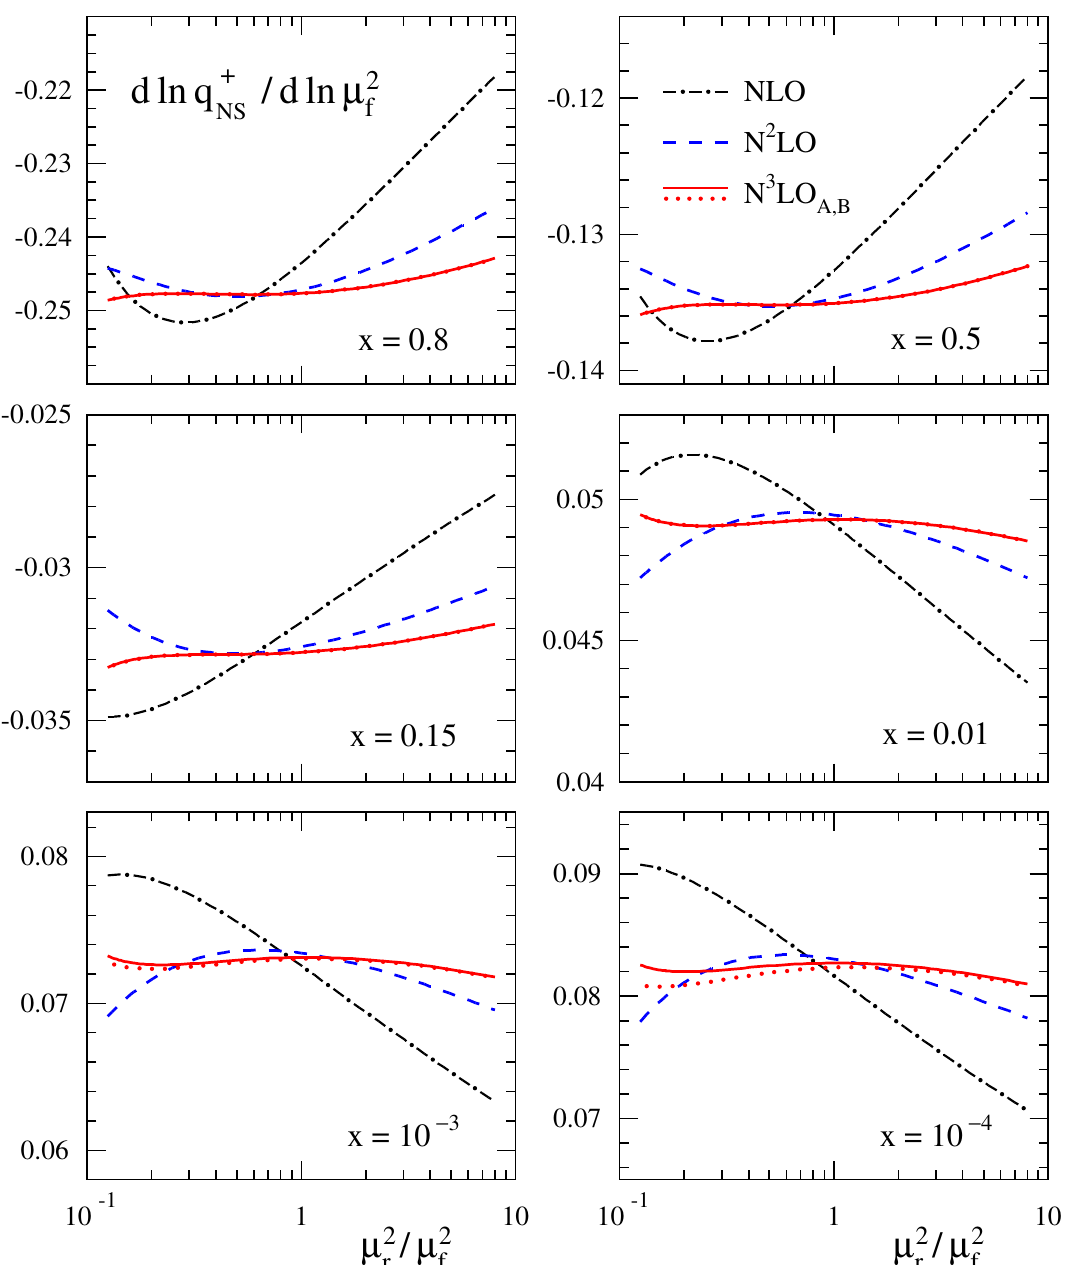
Figure 9 . The dependence of the NLO, NNLO and N 3 LO predictions for _ q + on the renormalization scale (cid:22) at six typical values of x for the initial conditions (5.6) and (5.7). r The e(cid:11)ect of the remaining uncertainty of the four-loop splitting function P (3)+ ns , indicated by the di(cid:11)erence of the solid and dotted curves, is practically invisible except for the last two panel.